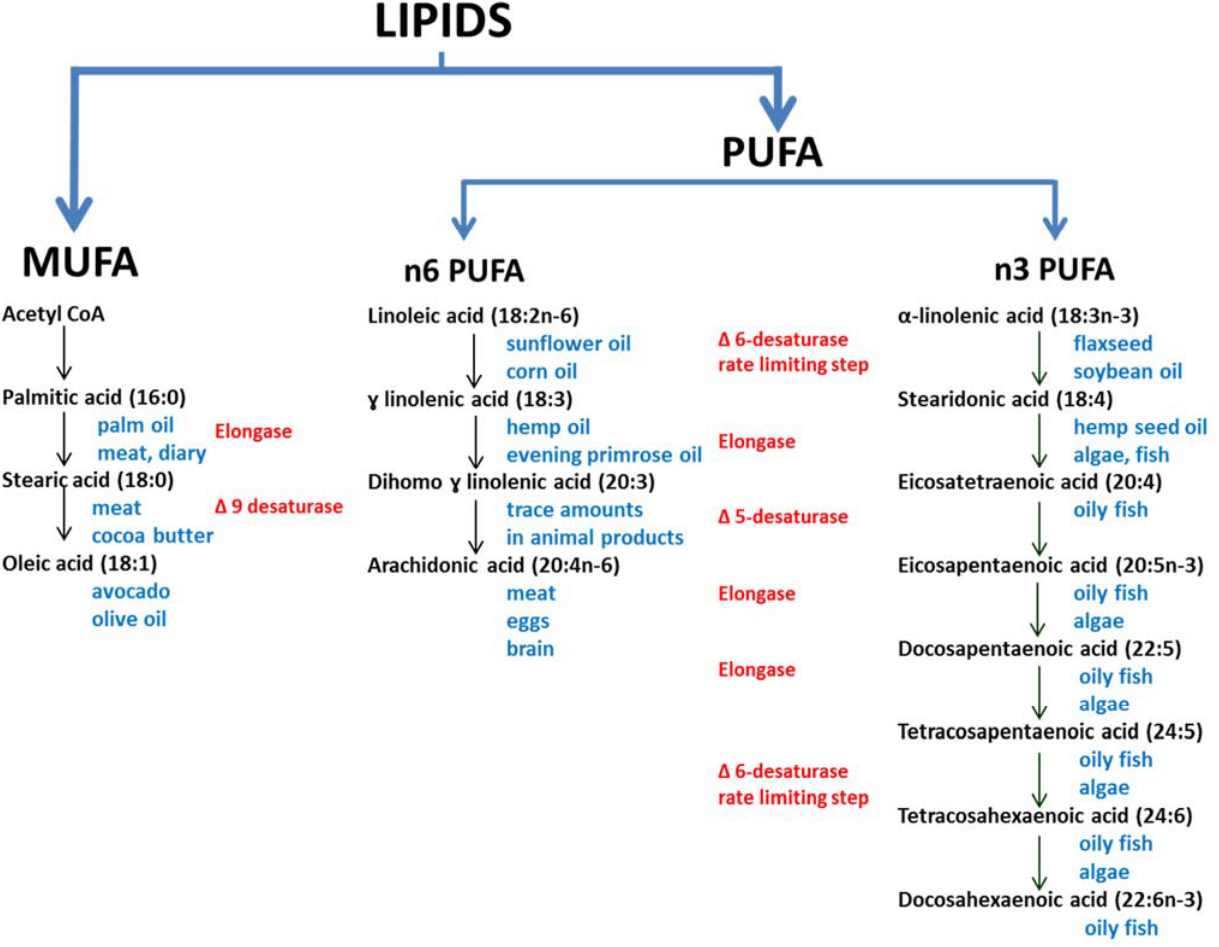
Figure 1. The biosynthesis pathways of the omega 3, 6 and 9 family of poly- and mono-unsaturated fatty acids (adapted from [21–23]).The main dietary sources are shown in blue text, and the enzymes in red